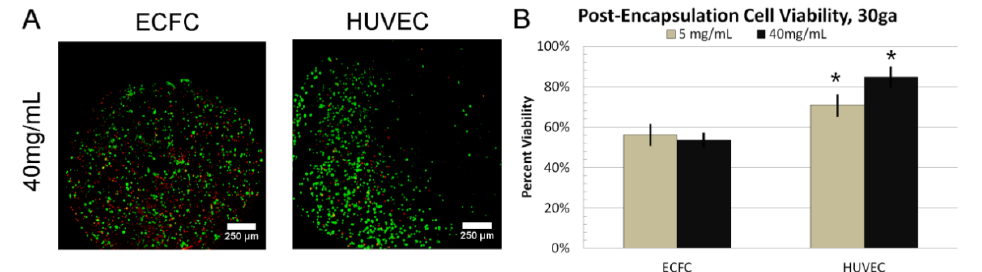
Figure 6. Cell Viability 24h Post-Encapsulation: ( A ) Image showing live/dead staining assay for various types of endothelial cells; ( B ) Graph showing viability data for ECFCs and HUVECs, at 5 or 40 mg/mL fibrinogen concentration ( * indicates p < 0.05).